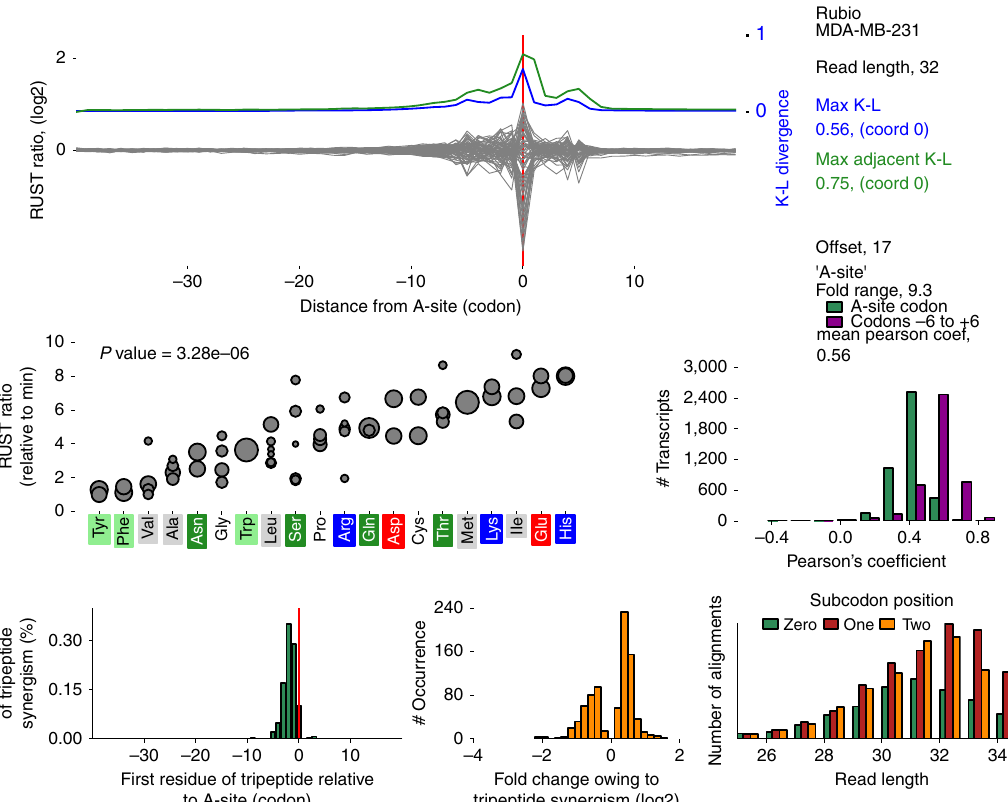
Figure 5 | An example of information provided for each data set with RUST Software. RUSTmetafootprint analysis for codons is shown at the top. Blue indicates Kullback–Leibler (K–L) divergence for individual codons and green for two adjacent codons. Zero coordinate corresponds to the inferred position of the A-site. Middle left plot shows RUSTratios ( y axis) for individual codons ordered by encoding amino acids at the axis x , the size of the disc indicates the codon usage. Middle right plot illustrates the ability of RUSTparameters to reconstruct experimental densities (green—based on identity of the A-site codons and violet is based on all codons within footprints). Bottom left plot shows locations of observed synergistic effects between amino acids that affect decoding rates, the bottom middle plot shows their strength and the bottom right plot illustrates the triplet periodicity signal for footprints of different lengths. This information is available for each data set used in this study at